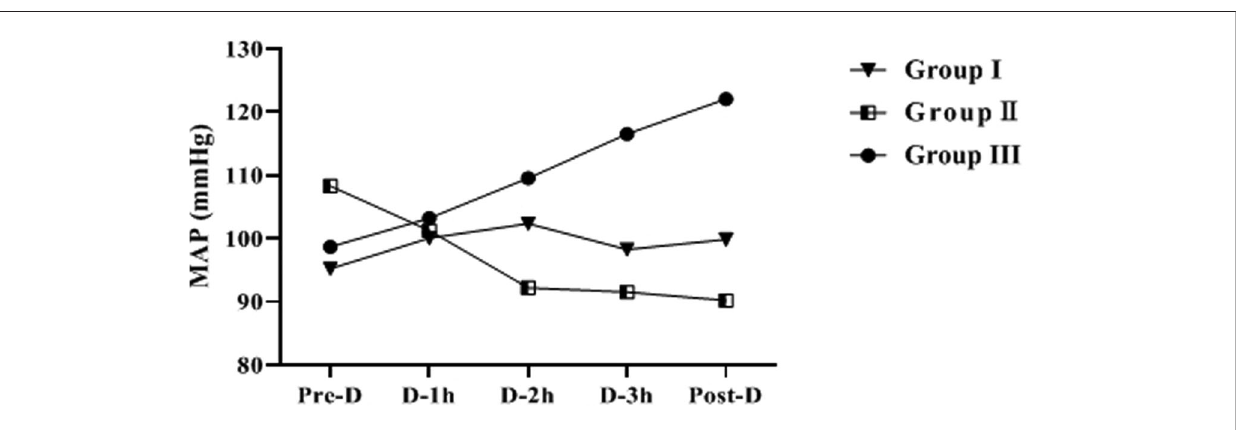
FIGURE 3 | Trend of MAP changes during dialysis in 3 groups.